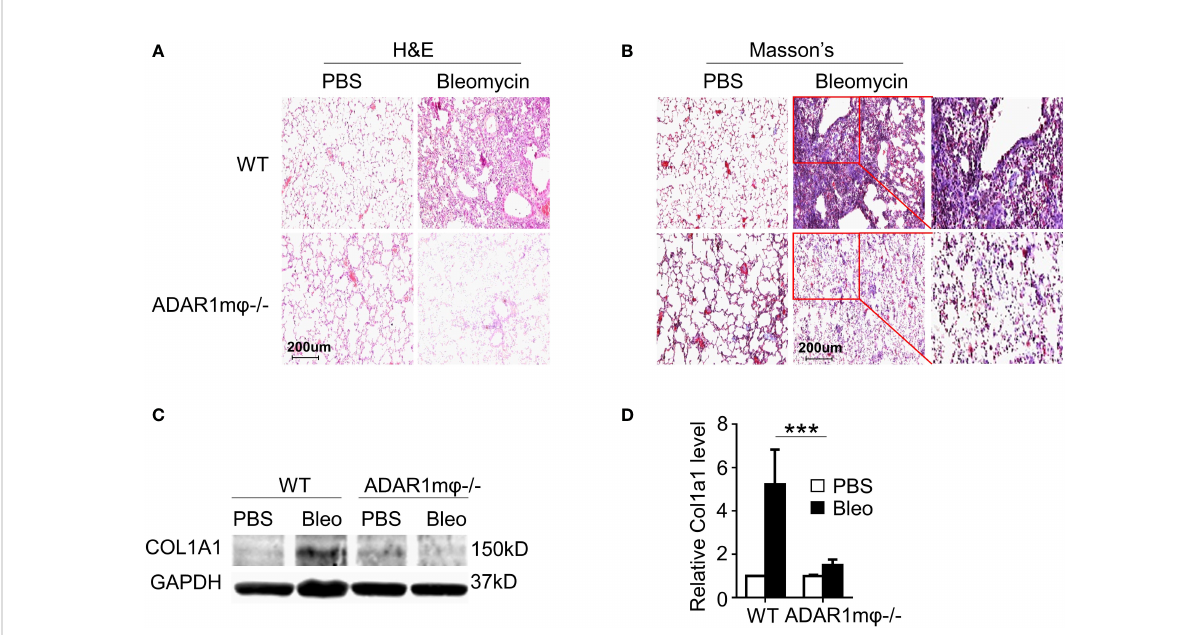
FIGURE 3 ADAR1m j -/- blocked bleomycin induced lung fi brosis. Lung fi brosis was induced in WT and ADAR1m j -/- mice by bleomycin injection (0.2U) for 24 days. (A, B) ADAR1m j -/- inhibited bleomycin-induced structure damage and collagen deposition in lung as shown by H&E staining (A) and Masson ’ s trichrome staining, respectively. 20x power of objective lens was used to acquire images. (C) ADAR1m j -/- blocked bleomycin-induced COL1A1 expression in lung tissues, as determined by Western blotting. (D) COL1A1 protein levels in C were quanti fi ed by normalizing to GAPDH. ***P < 0.001, n = 6. 2-way ANOVA was used for comparison among